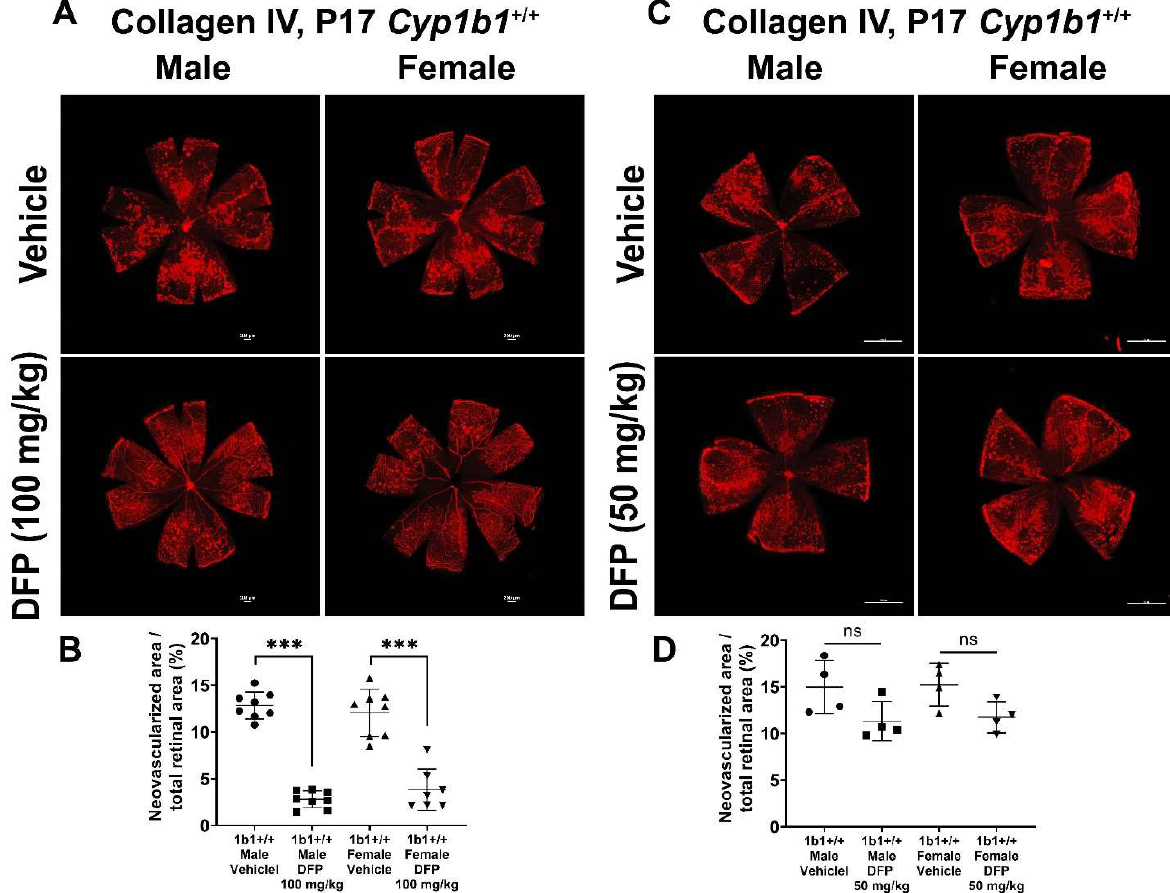
Figure 10. Effect of iron chelation by deferiprone (DFP) on retinal neovascularization in Cyp1b1 +/+ mice during OIR. Cyp1b1 +/+ mice were administrated with ( A ) 50 mg/kg or ( C ) 100 mg/kg of DFP (daily IP injection prepared in 50 µL saline, from P12 through to P17) in separate OIR experiments. Retinas from those mice at P17 were wholemount stained with anti-collagen IV antibody and imaged by fluorescent microscopy. Scale bars = 1000 µm. Quantitative assessment of the neovascularization was performed using ImageJ and percentages of neovascularized area from these groups are shown in ( B , D ) respectively (*** p < 0.001, ns: not significant, n ≥ 4; each point represents one retina).